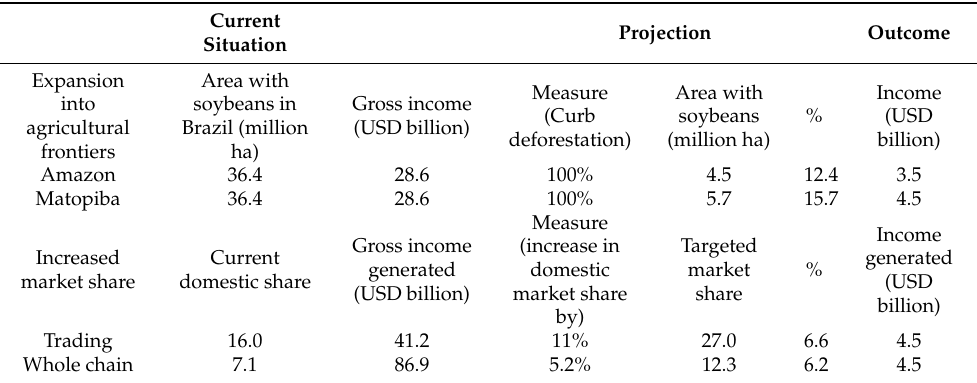
Table 4. Trade-offs between reducing investments in farming expansion and increasing market share in agro-industrial